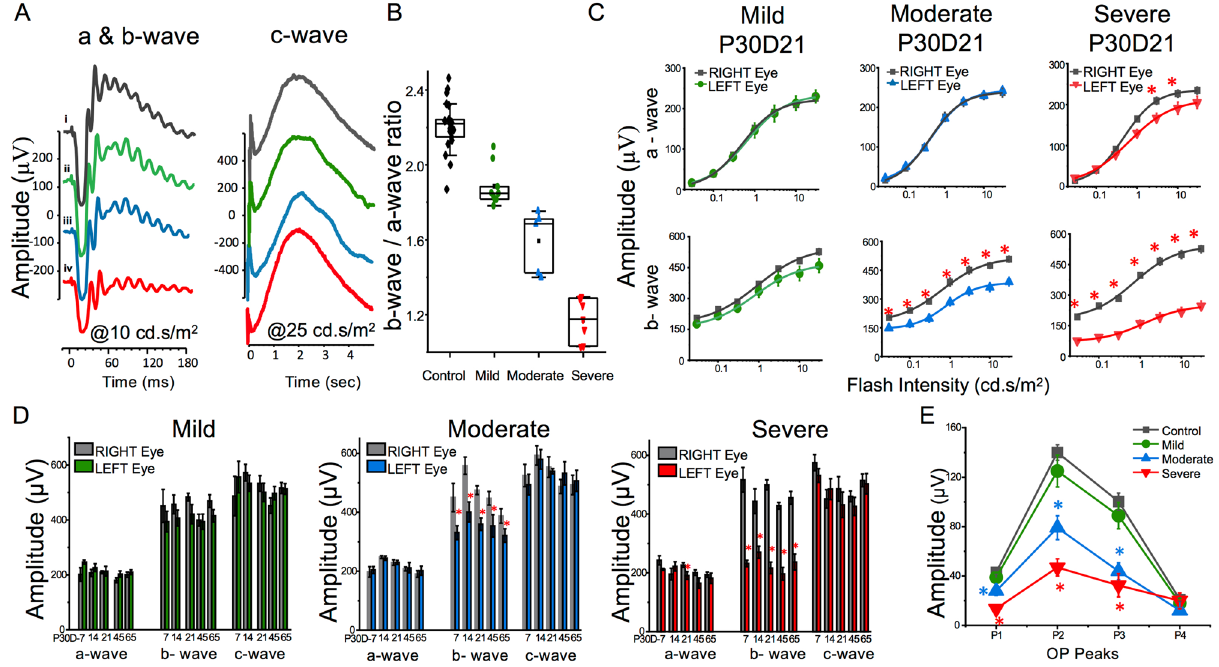
Figure 1. Abnormal dark-adapted electroretinogram (ERG) responses in juvenile mice after exposure to HI. ( A ) Representative ERG waveforms obtained from light flashes of 10 cd s/m 2 (a- and b-waves, left panel) and 25 cd s/m 2 intensities (c-waves, right panel) representing a control (right) eye (black) and HI exposed (left) eyes with different waveform profiles. At 10 cd s/m 2 ; some eyes were almost completely normal (green), some other eyes showed a slight reduction in b-wave amplitude (blue) and a third group of eyes showed a substantial reduction in both a- and b-wave amplitudes (red). The c-waves of the same representative HI exposed eyes as in left panel were unaffected. ( B ) Shows the average plot of b/a ratio of control eye group and the three groups (mild, moderate, or severe groups) of HI injured eyes. ( C ) Shows amplitude (µV) of a-waves and b-waves in response to a series of intensities of single light flashes in control eyes, and in eyes with mild, moderate, and severe P30D21 HI injuries. Solid line is the Naka Rushton exponential fit of the data as an intensity-response function. ( D ) Shows summary results for amplitudes of a-wave, b-wave and c-wave obtained from control eyes, and eyes with mild, moderate, and severe HI at P30D7, P30D14, P30D21, P30D45 and P30D65. Peak amplitudes were collected at flash intensity 10 cd s/m 2 for a-wave and b-wave and 25 cd s/m 2 for c-wave. ( E ) shows amplitude responses of the four major oscillatory potential (OP) peaks of control eyes, and from eyes with mild, moderate, and severe HI exposure. Data from 21 animals from three cohorts (N = 6, 7, 8 animals) were analyzed and presented as mean ±